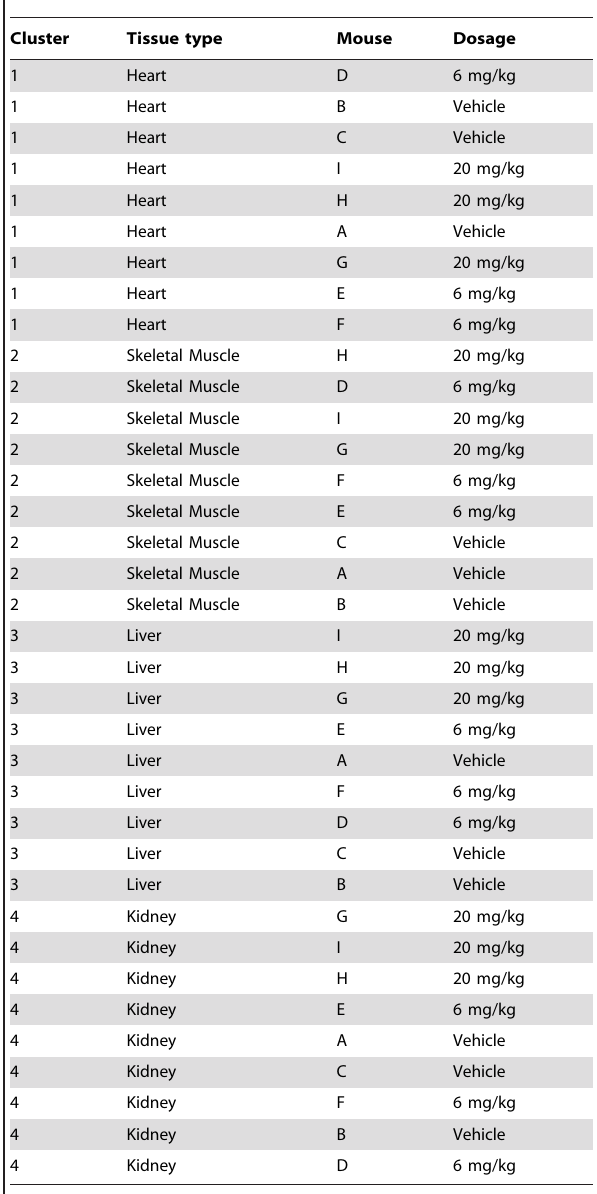
Table 2. Ordering of the tissue samples after single factorization of rank 4 of the entire dataset.